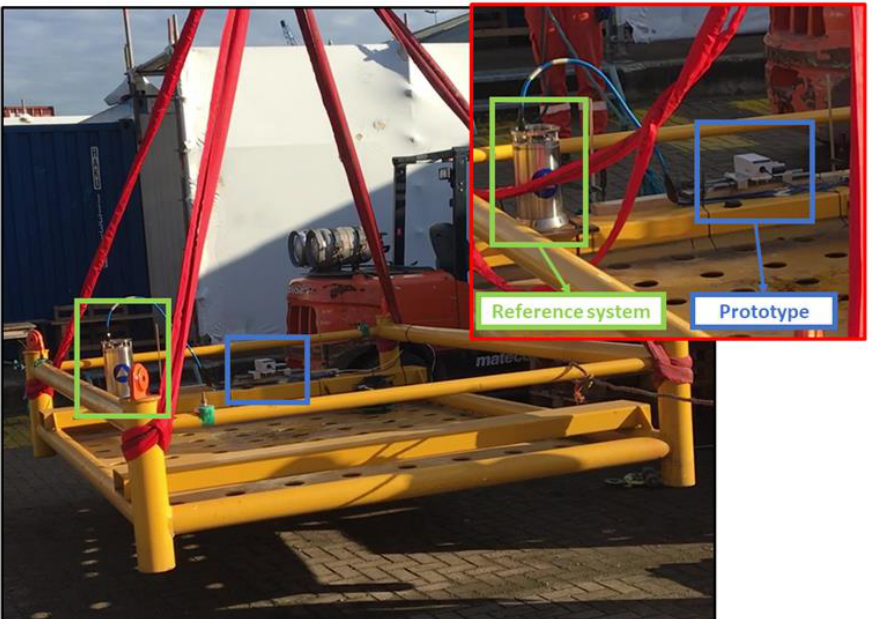
Figure 10. Prototype and reference system installed on the oscillating platform exploited for comparison tests.